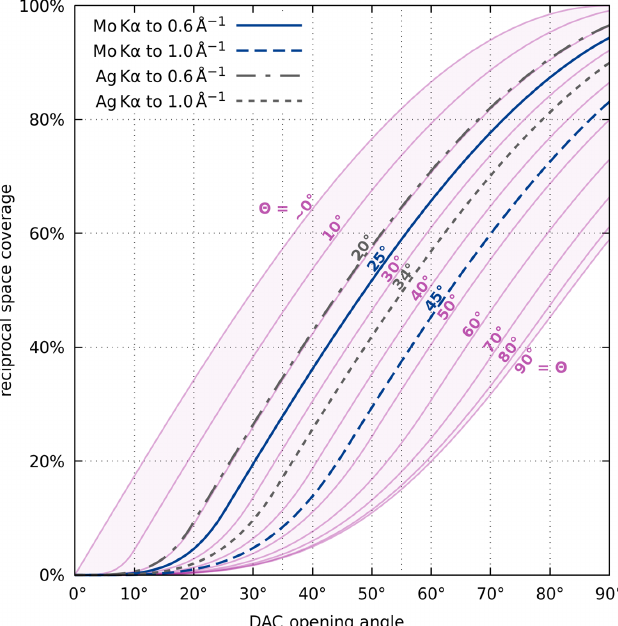
Figure 3 Reciprocal space coverage as a function of opening angle (cid:2) presented for a series of (cid:2) limits according to Equation (4). The (cid:2) lines which translate into the most common combinations of radiation wavelengths and resolution limits have been highlighted. Assumed Laue class: (cid:3)